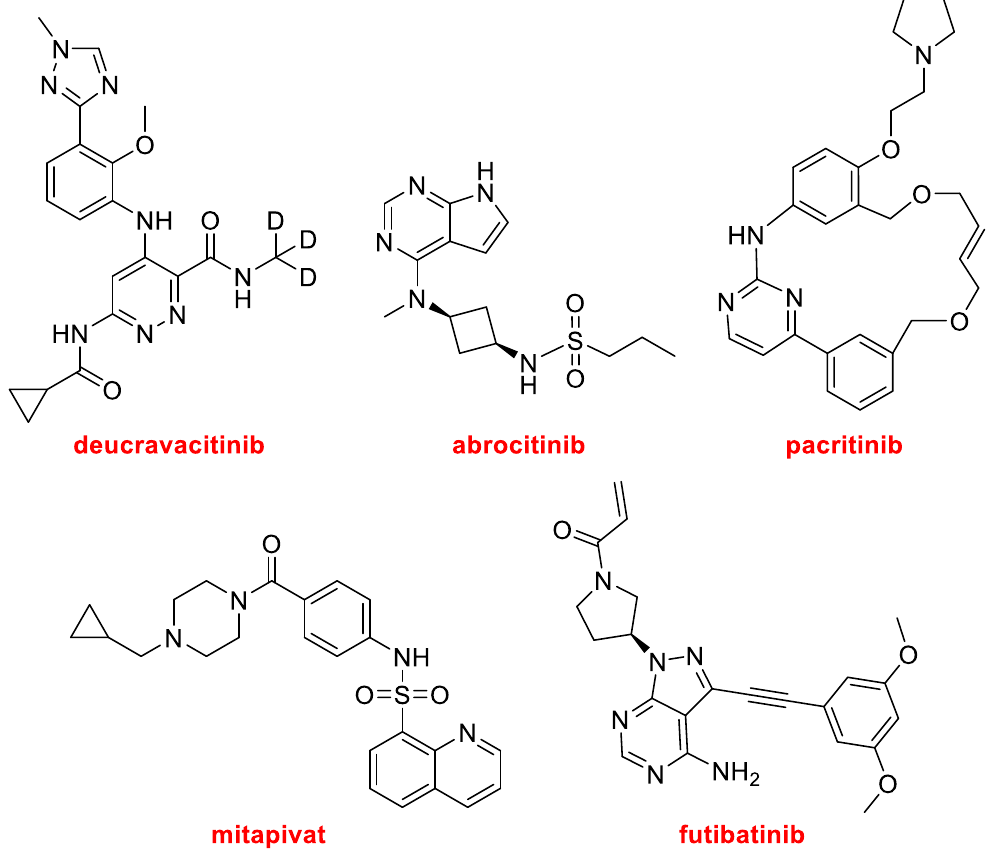
Figure 12. Structures of the kinase-related drugs deucravacitinib, abrocitinib, pacritinib, futibatinib, and mitapivat.